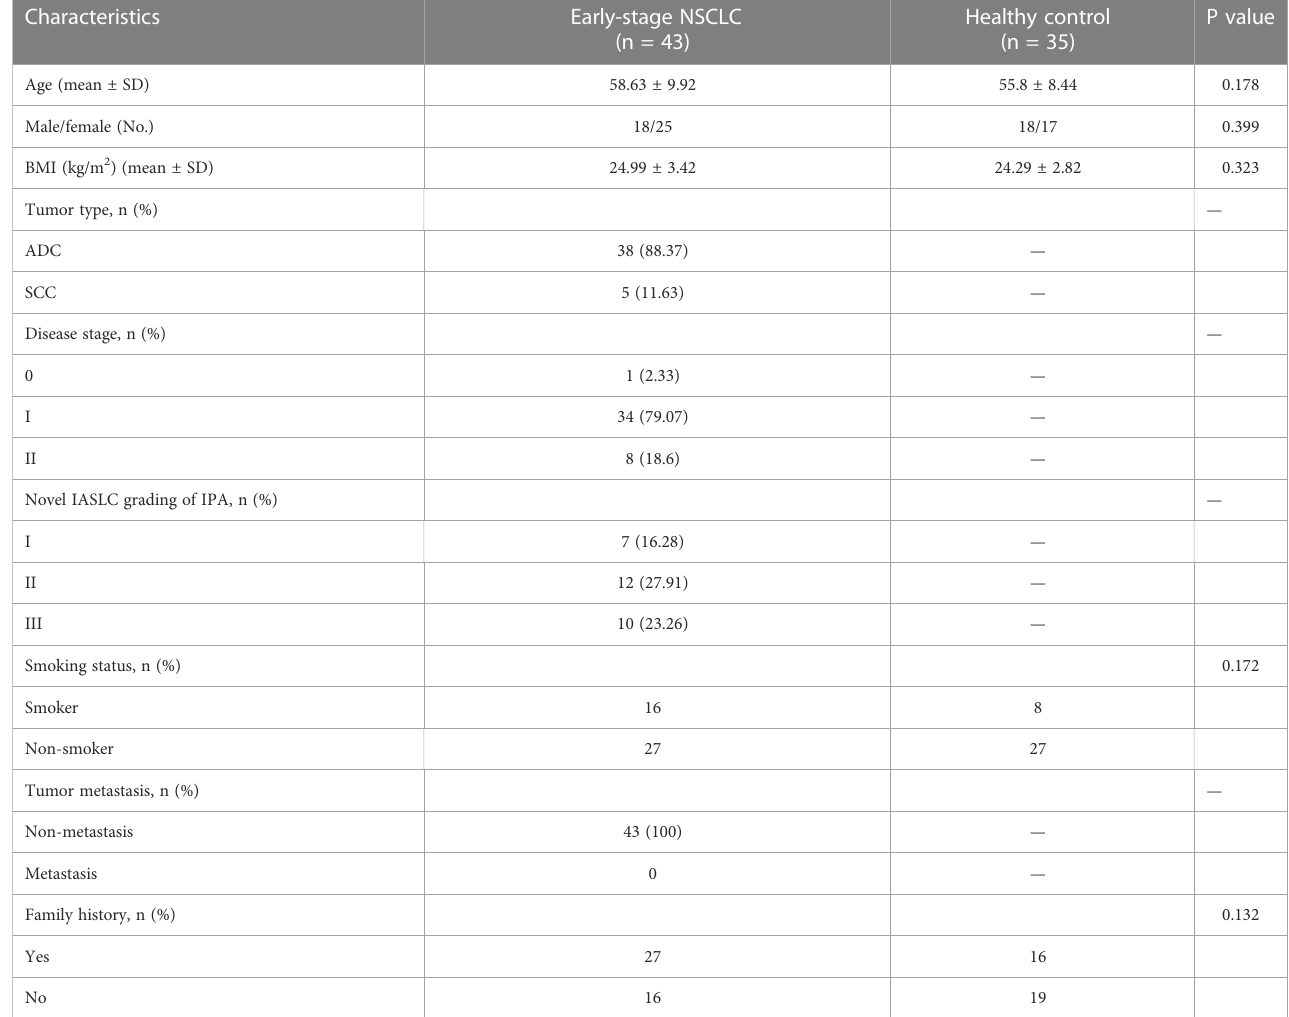
TABLE 1 Characteristics of health people and early-stage NSCLC patients.